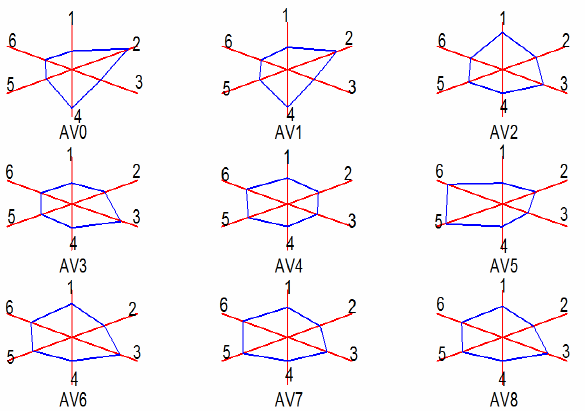
Fig. 1. Wine finger printing obtained by a multivariate data analysis of aroma compounds grouped by chemical families. 1: terpenes and nor-isoprenoids, 2: aldehydes and ketones, 3: alcohols, 4: benzene compounds, 5: acids, 6: